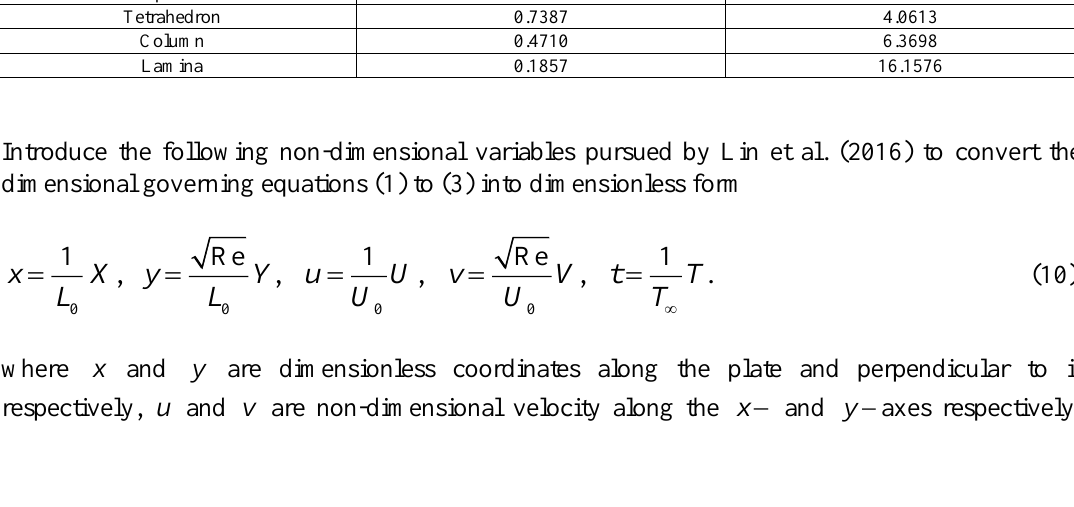
Table 2. Mathematical values of  and m for distinct nanoparticle shapes